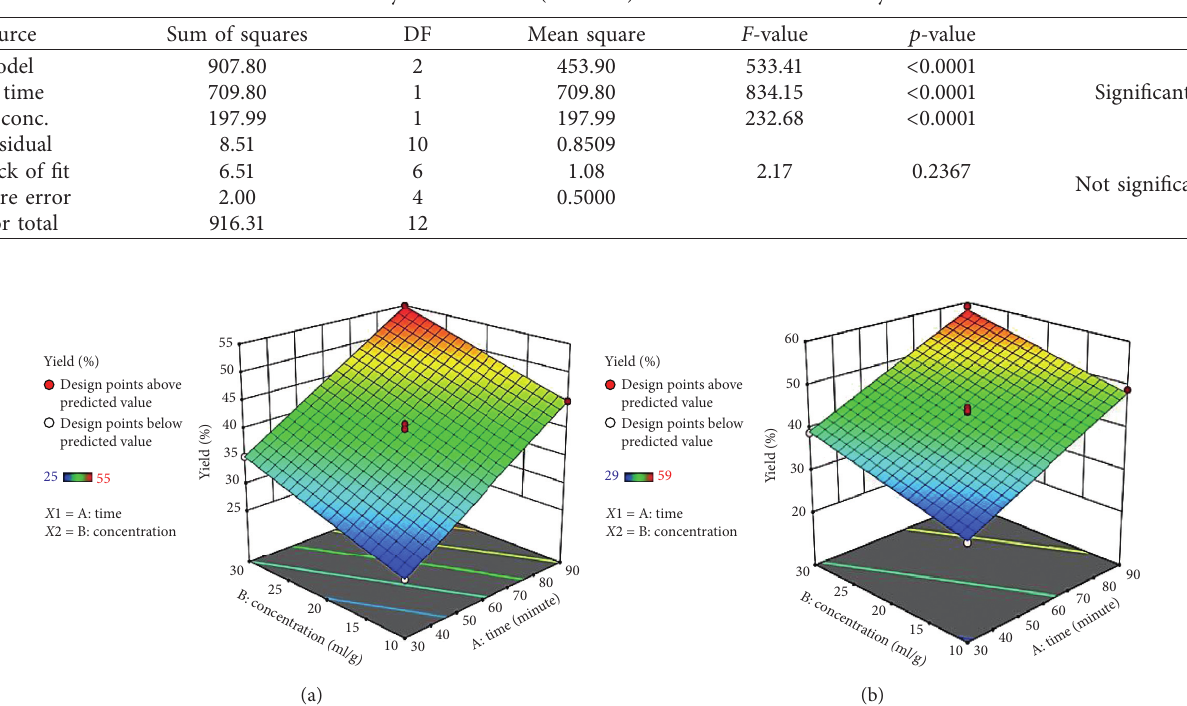
Figure 3: Interaction of factors time and temperature on (a) water and (b) ethanol extraction